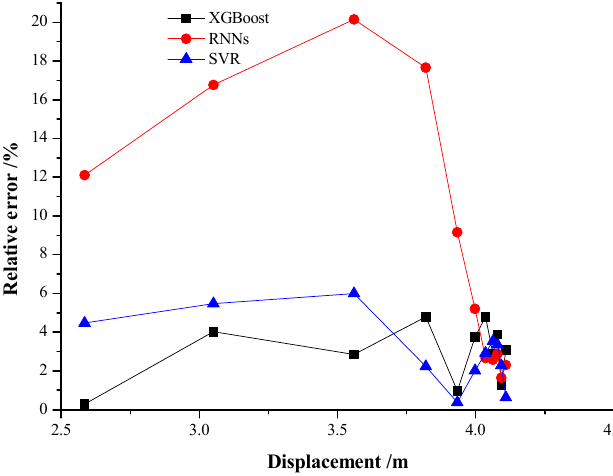
Figure 15. Variation of RE with slope displacement of D9.